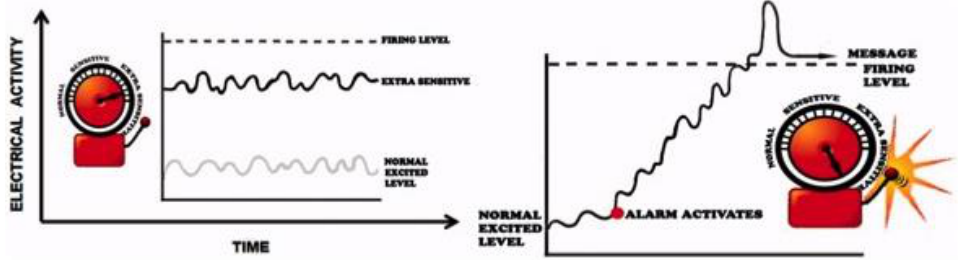
Figure 4. Example of illustration used in the PNET program to explain nervous system processes related to persistent pain. Reprinted from Louw, A.; Puentedura, E.J.; Diener, I.; Peoples, R.R. Preoperative therapeutic neuroscience education for lumbar radiculopathy: A single-case fMRI report